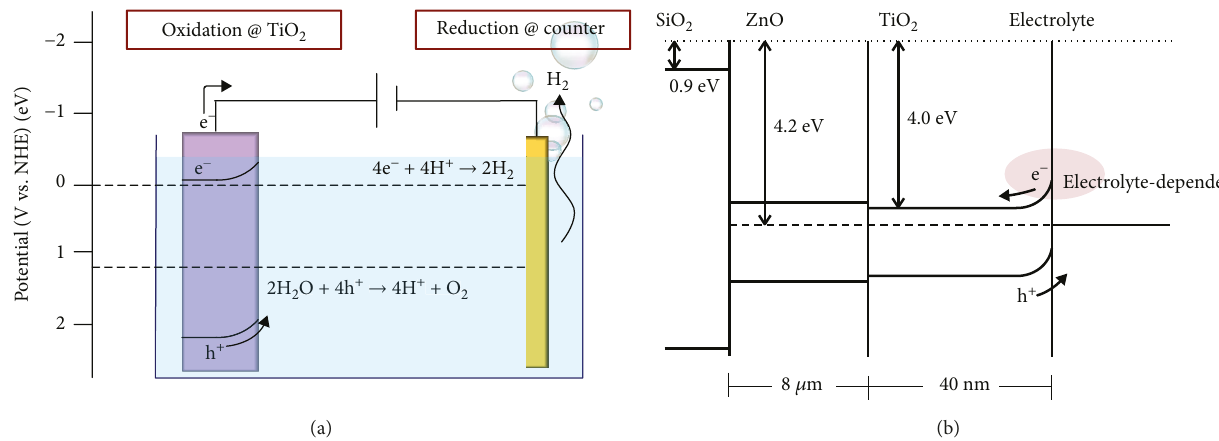
Figure 1: (a) Water splitting cell: incident light creates photogenerated electron-hole pairs. Given an appropriate band structure (straddling water reduction/oxidation potentials), holes and electrons will oxidize water at the photoanode and reduce resulting H + ions at the cathode, respectively. These reactions result in oxygen and hydrogen gas production. (b) Proposed band gap structure of TiO TiO experiences charge separation at the electrolyte-TiO interface, moving holes into the electrolyte and electrons into the single-crystalline 2 2 ZnO